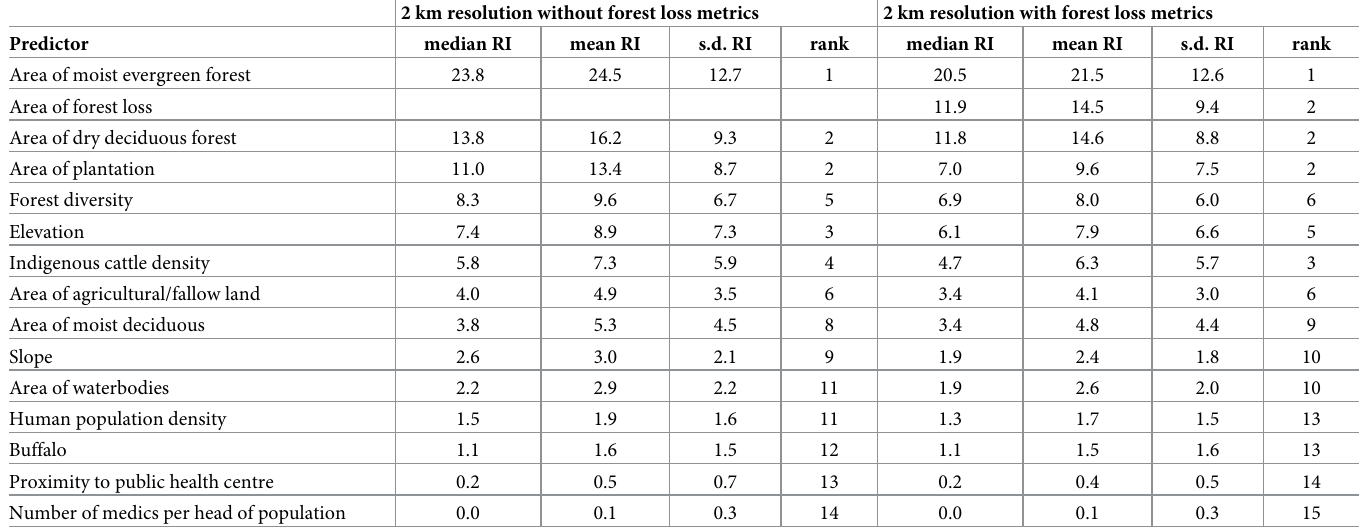
Table 6. Relative importance of predictors in BRT models at a 2 km resolution (median, mean and s.d. of values across 100 model runs). 2 km resolution without forest loss